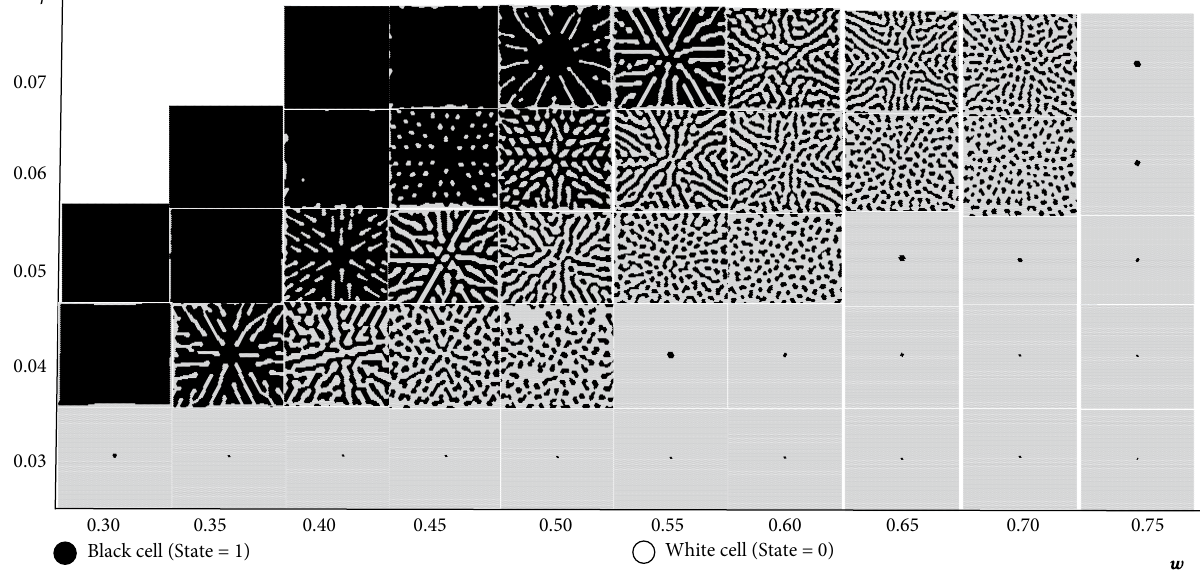
Figure 9: Simulation results for w and ( w = 0.3 − 0.75, b = 10, 000, d = 0.008). Parameter r is the residual ratio of morphogen in each cell. Spatial patterns appear for 0.04. The residual rate has the same effect as w , i.e., it controls the transition from spotted patterns to striped 푟 ≳